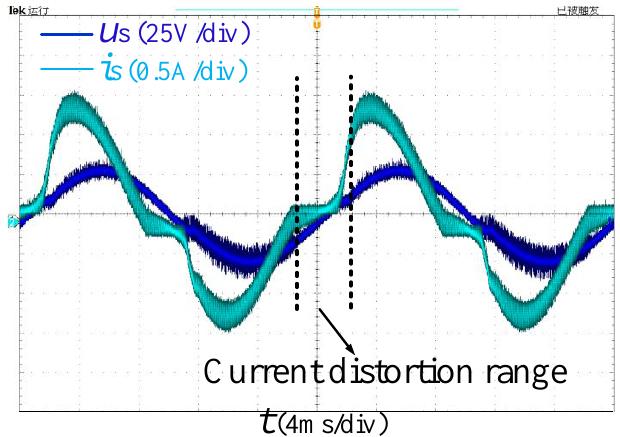
Figure 24. Experiment waveforms of grid voltage and input current under leading power factor.